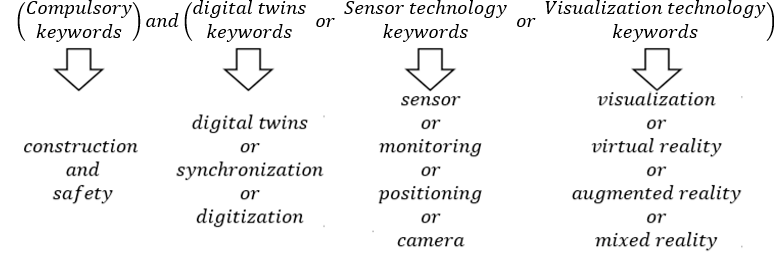
Figure 3. Keywords for the literature retrieval.